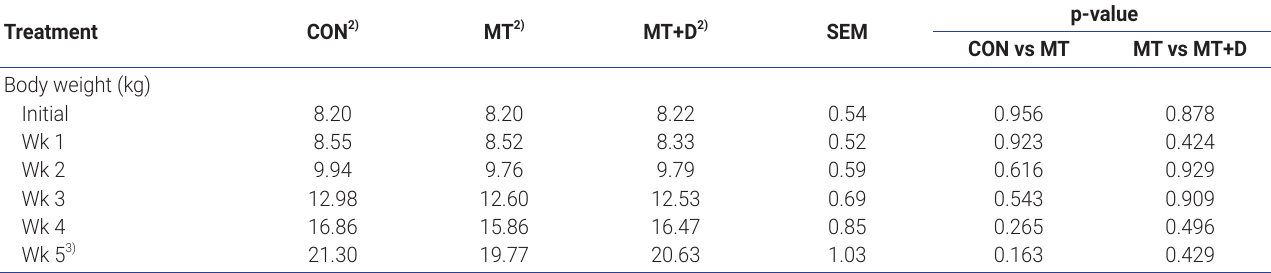
Table 4. Body weight of weaned pigs consuming experimental diets with (MT 1) ) or without mycotoxins (CON) for 5 weeks Treatment